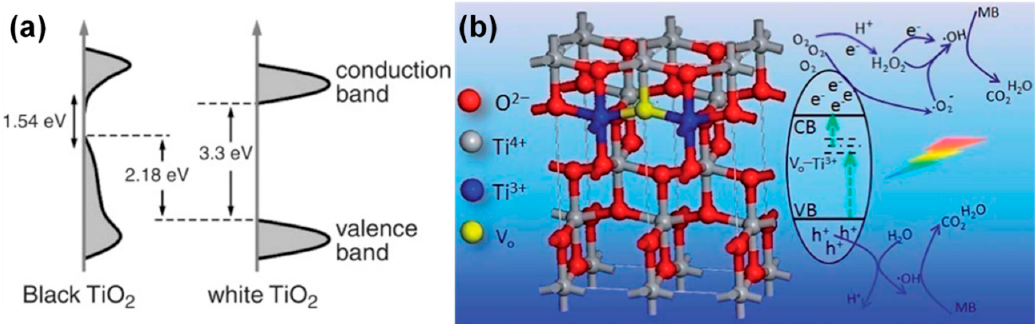
Figure 18. Band gap structure of ( a ) black-TiO 2 and ( b ) blue-TiO 2 (reproduced with permission from refs. [235,236]).